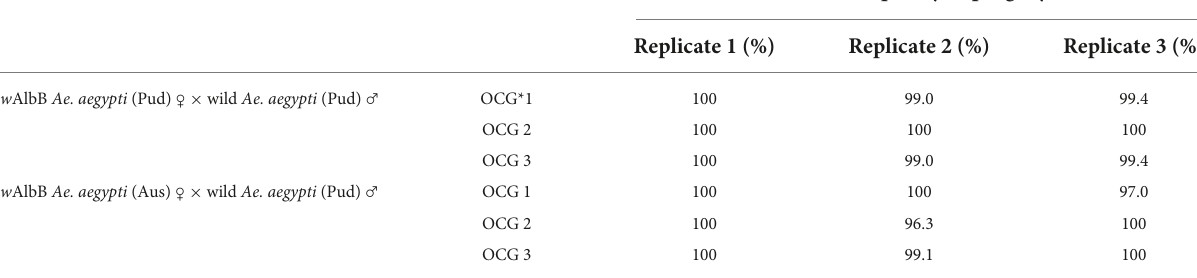
TABLE 2 Maternal transmission of Wolbachia assessed from the progeny of crosses between w AlbB-infected Ae. aegypti females and uninfected wild Ae. aegypti males. Crosses